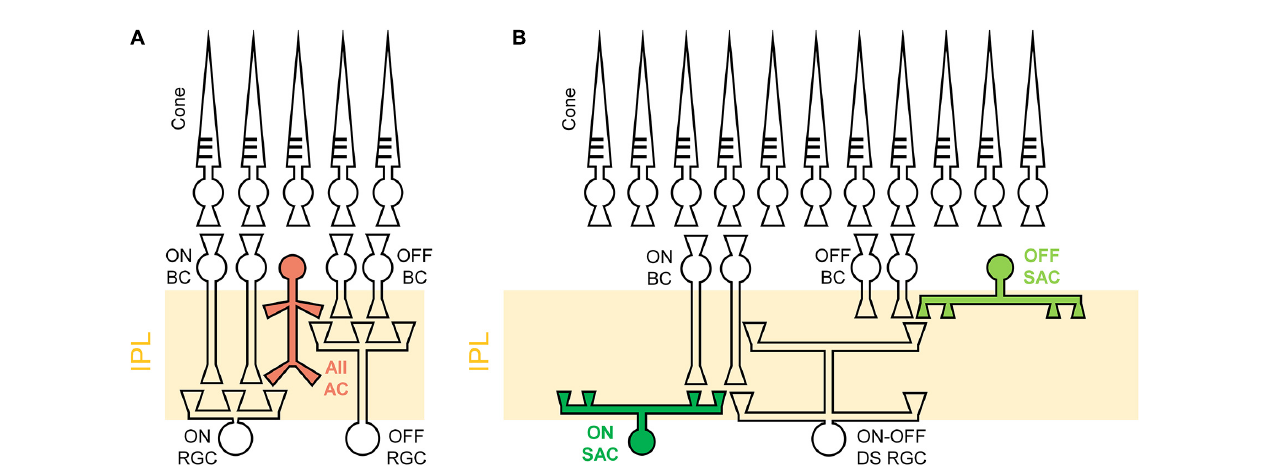
FIGURE9 Schematic illustrations of different retinal circuits between non-DS and DS RGCs. (A) AII amacrine cell (AC) has a narrow field of bistratified dendrites to ON and OFF RGCs. (B) Starburst amacrine cells (SACs) stratify their dendrites to a relatively wide area to modulate direction-selective light responses of DS RGCs. IPL, Inner plexiform layer; BC, bipolar cell; RGC, retinal ganglion cell; AII AC, aII amacrine cell; SAC, starburst amacrine cell; DS RGC, directional selective retinal ganglion cell. Rod pathways are not illustrated for